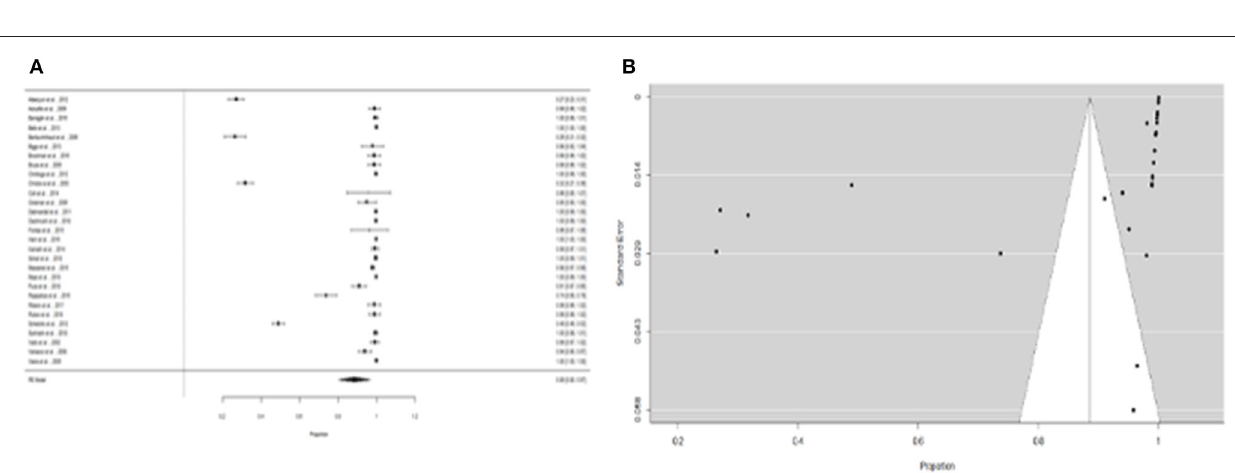
FIGURE 3 | (A) Forest plot of the proportion of “fever and two more symptoms” for suspicious patients of leptospirosis. (B) Funnel plot of the proportion of “fever and two more symptoms” for suspicious patients of leptospirosis.